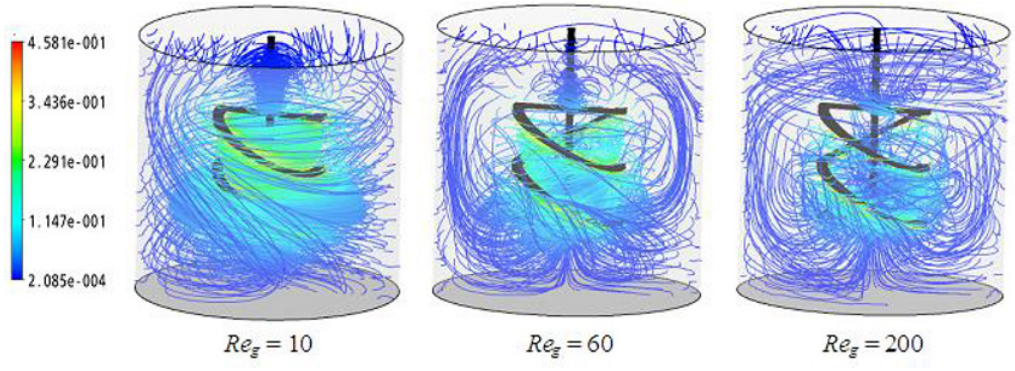
Figure 11. Flow fields for double helical ribbon impeller, at n = 0.6, c/D = 0.26, h/D = 0.5.